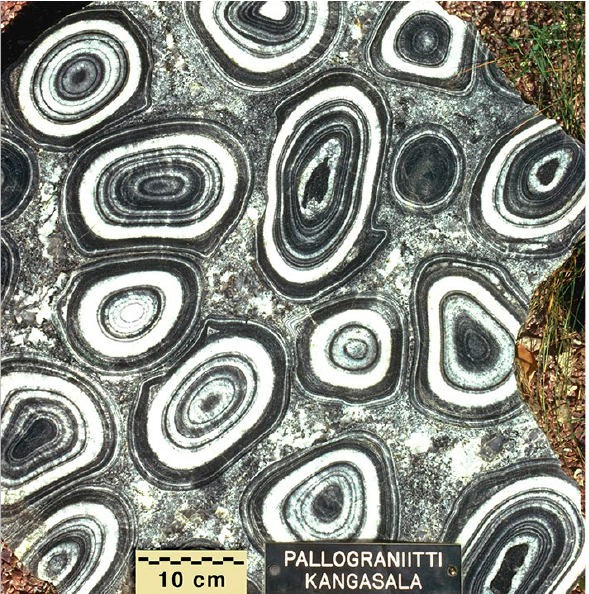
Figure 32. Termier and Termier 4 (1970) found an echinoderm shell within a granite feldspar crystal in the Atlas Mountains in